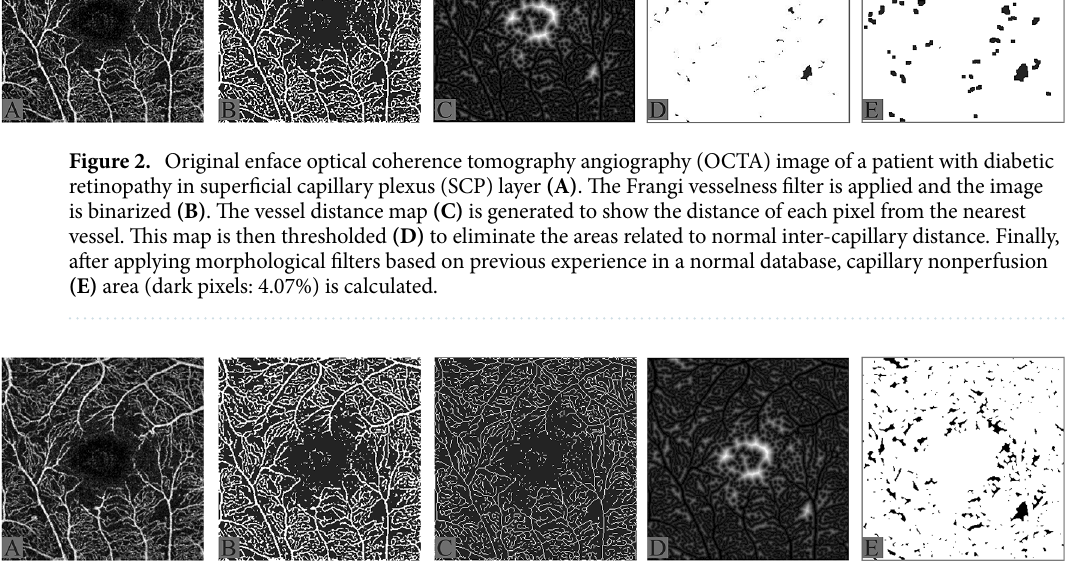
Figure 3. Original enface optical coherence tomography angiography (OCTA) image of a patient with diabetic retinopathy in superficial capillary plexus (SCP) layer (A) . The Frangi vesselness filter is applied and the image is binarized (B) . The image is then skeletonized (C) and the vessel distance map (D) is generated based on the skeletonized image to show the distance of each pixel from the nearest vessel. This map is then thresholded (E) to eliminate the areas related to normal inter-capillary distance, and geometric perfusion deficit area (dark pixels: 5.96%) is